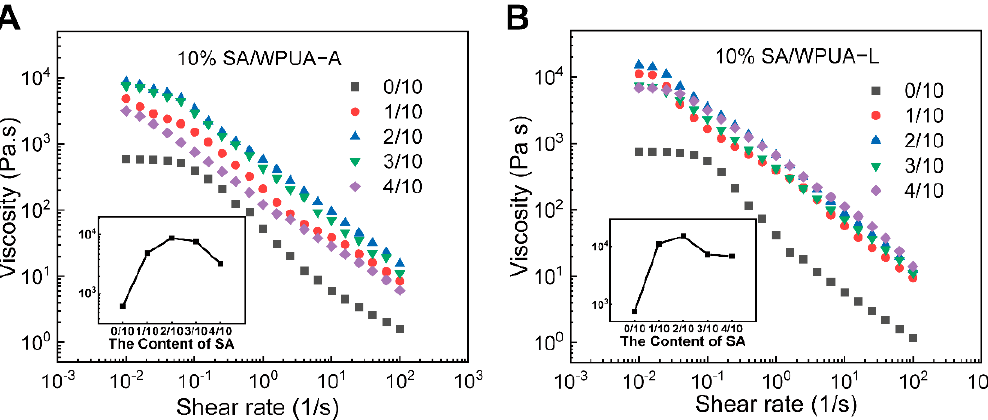
Figure 4. The steady-state flow behavior of ( A ) WPUA − E and ( B ) WPUA − L composite inks were measured with viscosity curves.